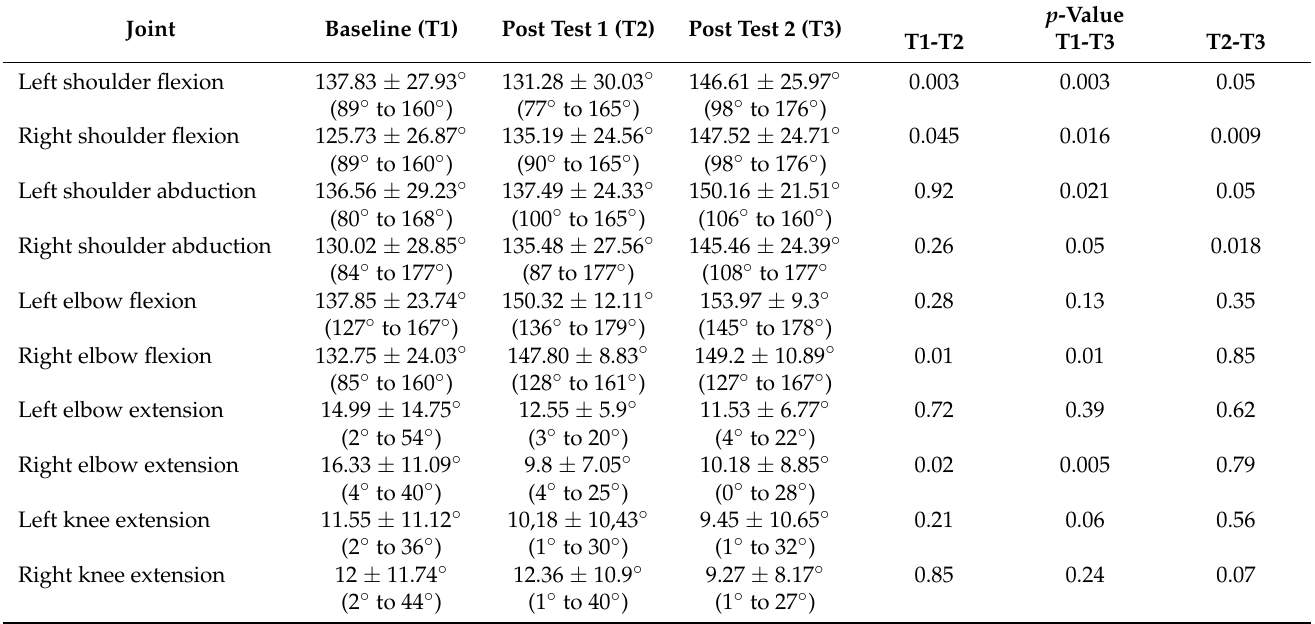
Table 2. Measurements and estimated p -value from the passive left shoulder and right shoulder movement